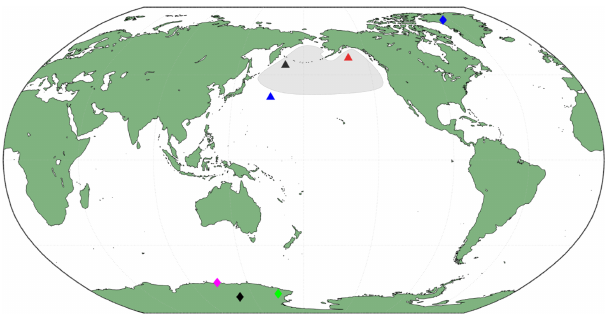
Figure 1. Location of the NEEM ice core (blue diamond; this study), the LD ice core (pink triangle; Edwards et al., 2006), the EDC ice core (black diamond; Wolff et al., 2006) and the TD ice core (green diamond; Vallelonga et al., 2013). We retrieved paleo- productivity data for the eastern North Pacific (black triangle) from the ODP882 (Haug et al., 1995) and SO202-27-6 (Méheust et al., 2018) sediments cores, and we retrieved these data for the western Pacific Ocean (red triangle) from the ODP887 (McDonald et al., 1999) and SO202-07-6 (Méheust et al., 2018) sediment cores. The paleoproductivity record from the midlatitude North Pacific was re- trieved from the S-2 sediment core (blue triangle; Amo and Mina- gawa,